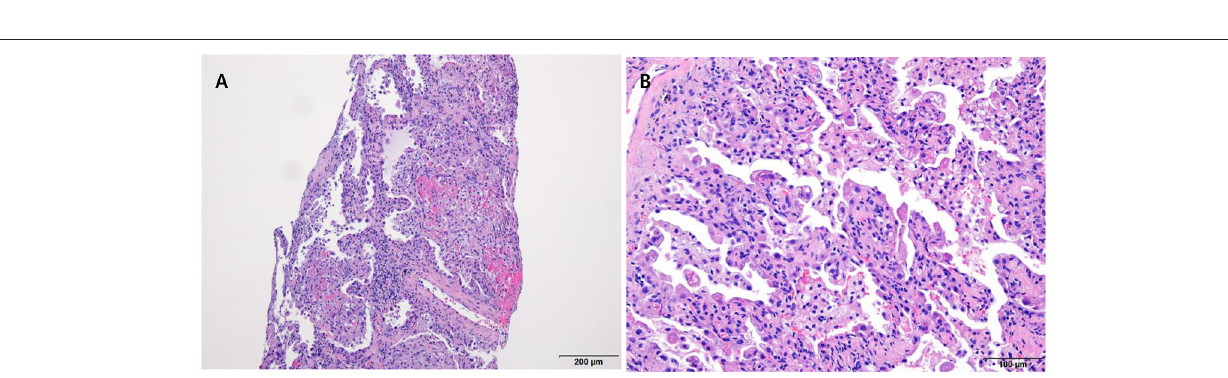
of previous lung lesions. After exclusion of lung malignancy after cessation of amiodarone for 1 month without any treatment